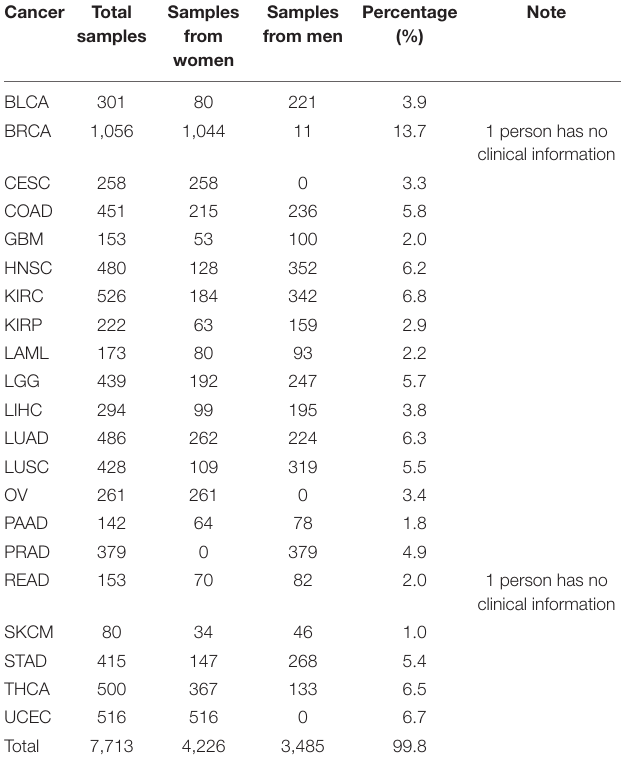
TABLE 1 | Detailed information of data covering 21 cancers downloaded from TGCA. Cancer Total Samples samples from